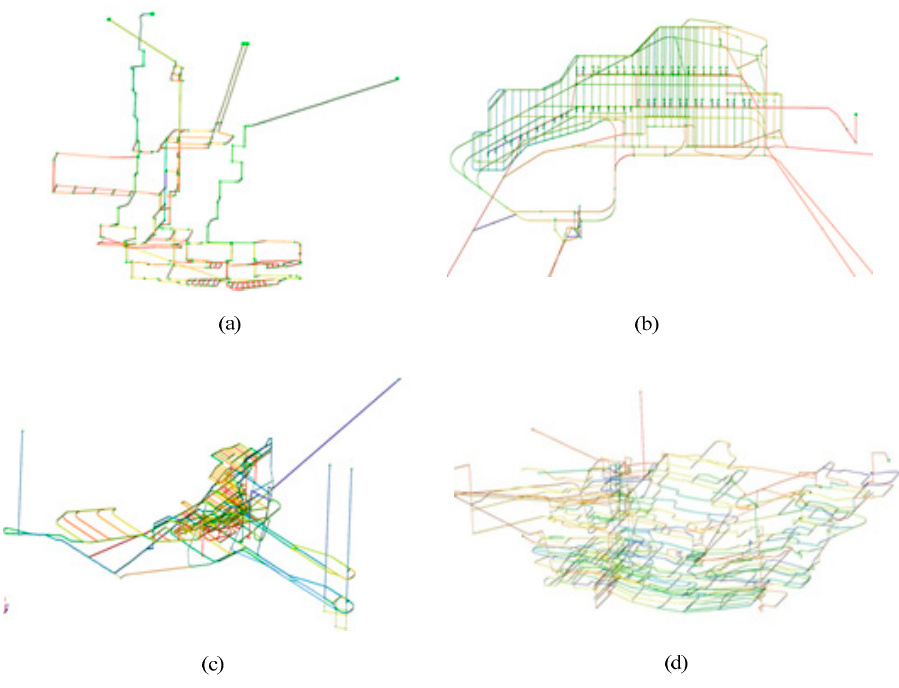
Table 1. Solution results of four actual mines, including the network and convergence parameters.